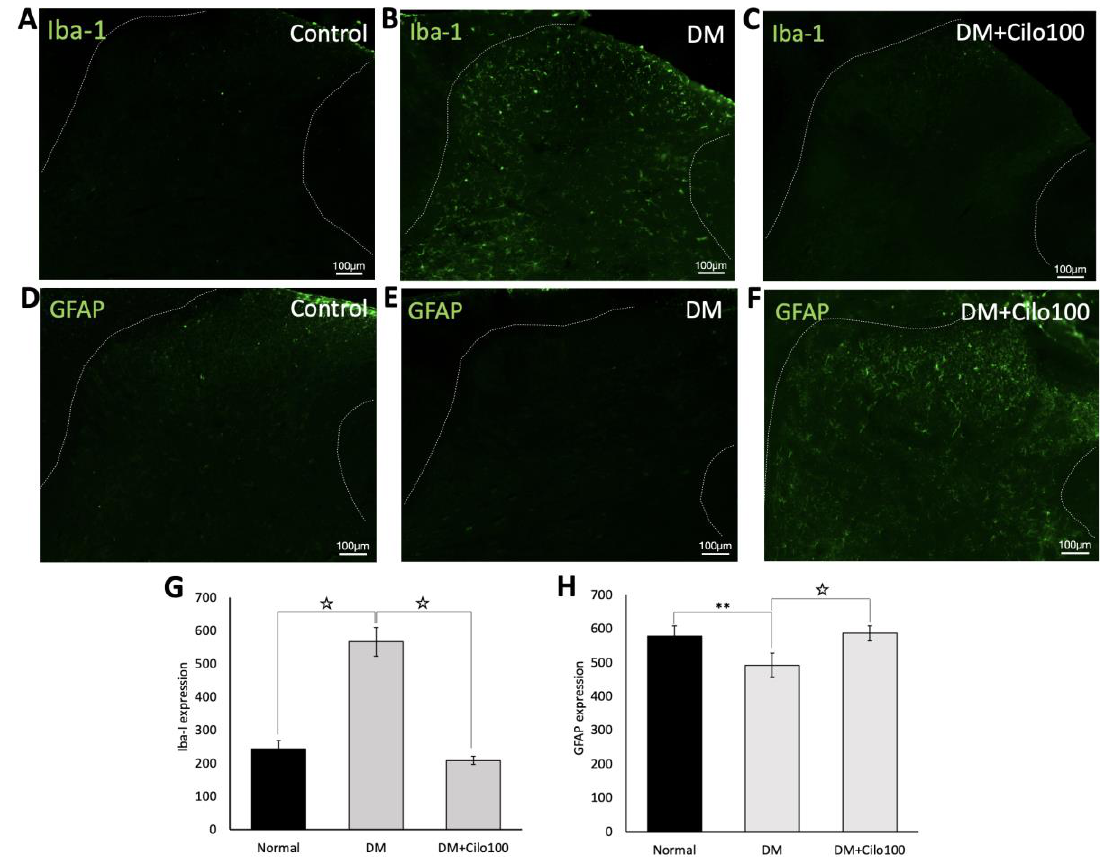
Figure 6. Reduced levels of microglia hyperactivation and increased levels of activated astrocytes in spinal dorsal horns of diabetic rats treated with cilostazol. Representative images of Iba-1 positive microglia ( A – C ) and GFAP positive astrocytes ( D – F ) expressions in spinal dorsal horns of ( A , D ) control, ( B , E ) DM, and ( C , F ) DM with cilostazol 100 mg/kg (Cilo100)-treated rats. Expressions of ( G ) Iba-1 positive microglia and ( H ) GFAP positive astrocytes in spinal dorsal horns are indicated as mean ± SEM for a minimum of five rats for each group. Expressions were measured in relative fluorescence levels. Error bars represent SE. ** Indicates significant difference at p < 0.01, and ☆ at p < 0.001, Mann – Whitney U test.